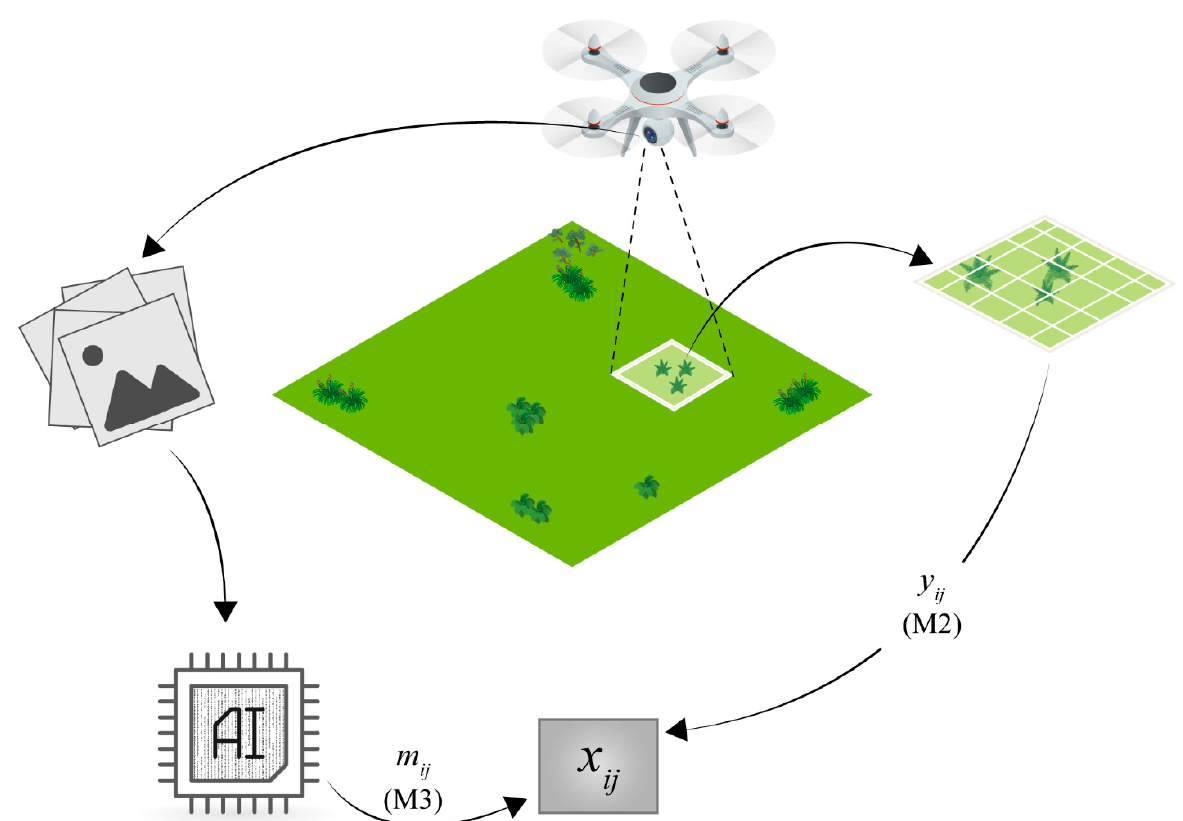
Figure 1. Outline of the hierarchical model for determining the uncertainty of the vertical density measured by the drone images. The true, but unknown, vertical density of species i at plot j in ground-truthing plot j is modeled by the latent variable x ij . The posterior distribution of the latent variable is calculated using both (i) the vertical density predicted from the information from the drone images using machine-learning algorithms ( m ij ) that are modeled using M 3, and (ii) the vertical density measured by the pin-point method ( y ij ) that is modeled using M